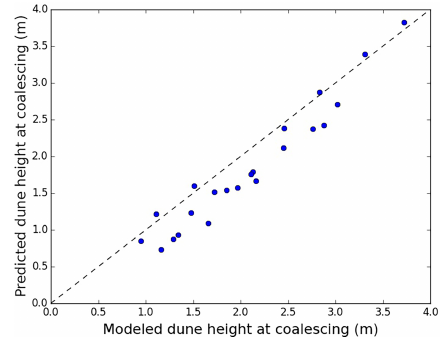
Figure 6. Modeled lateral dune propagation rate vs. predicted prop- agation rate from Eq. (4). Black line is 1:1.